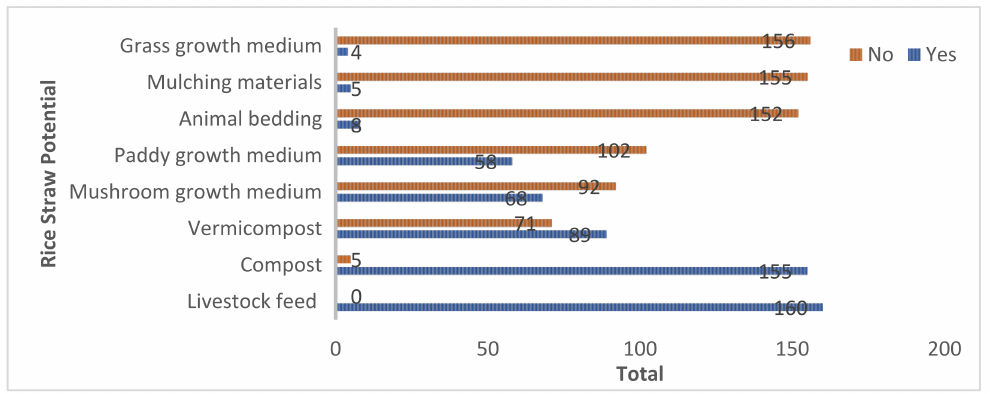
Figure 1. The farmer’s knowledge towards rice straw potential in the agricultural sector